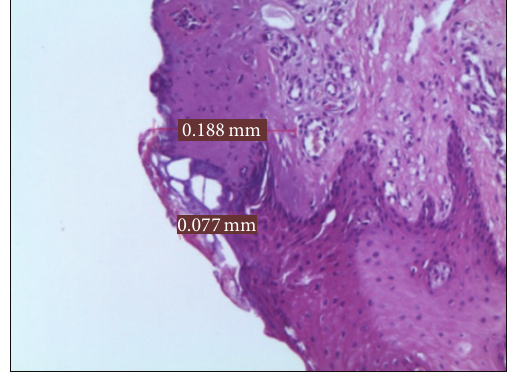
Figure 4: Histological specimen D 2 , using 3 watt in PW at 50 Hz, colour EE, magnification from original 40x.